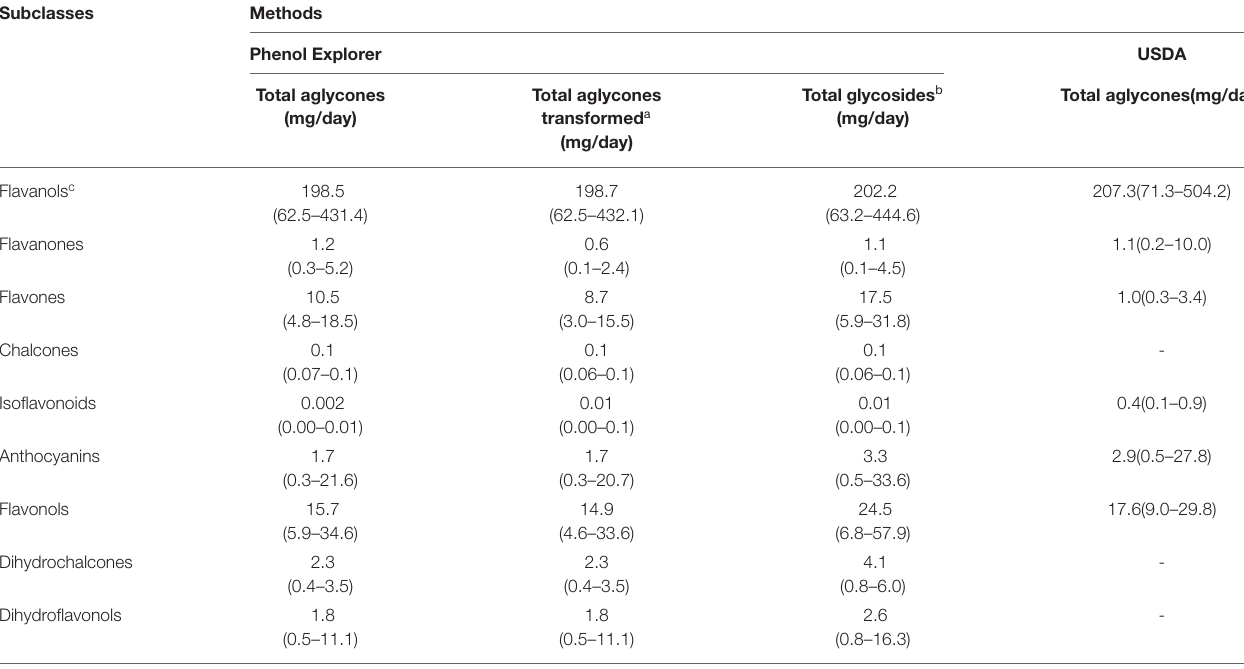
TABLE 3 | Total median of flavonoid subclasses by databases and